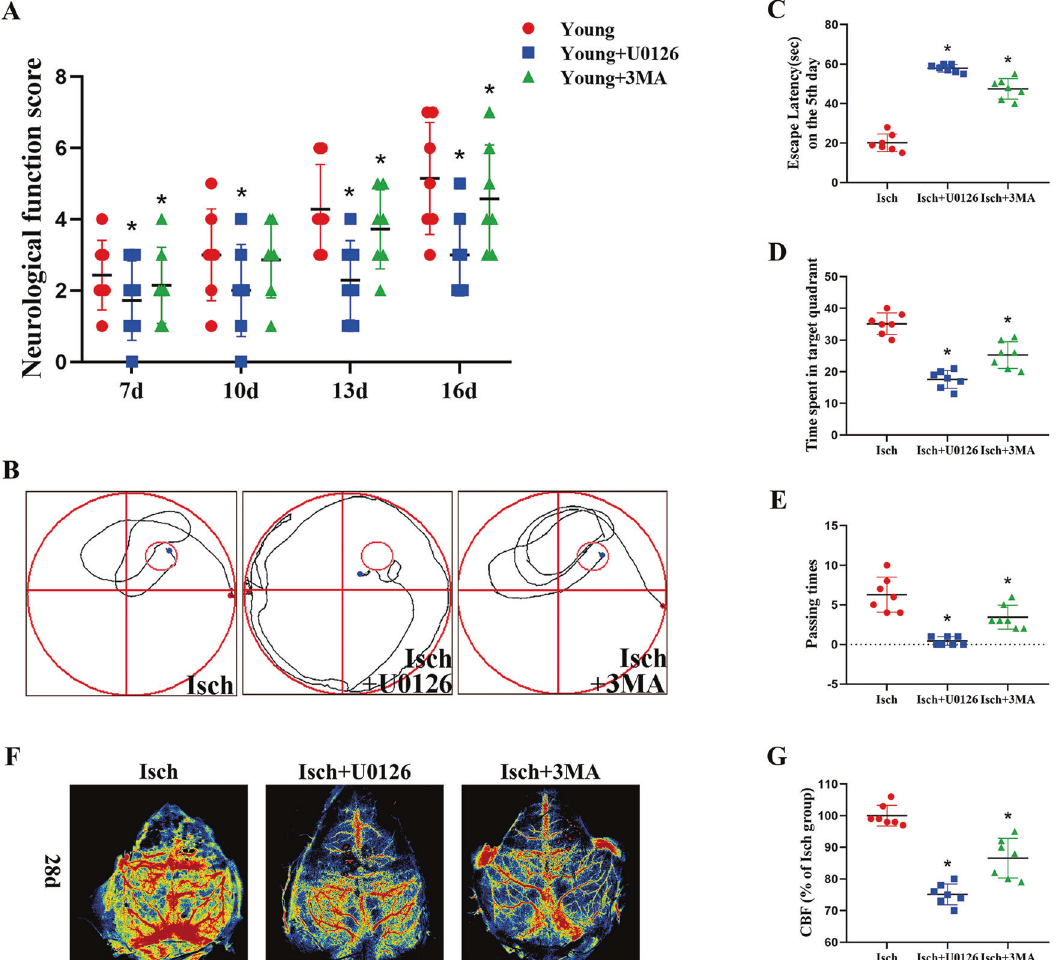
Fig. 4 Change of neurological function and recovery by U0126 or 3MA treatment. Neurological-function score of young gerbils treated with U0126 or 3MA after I/R ( A ). The maps of computer printouts of the swimming trajectories on the fi fth day of each group ( B ). The escape latency on the 5th day of each group ( C ). The time spent in target quadrant on the last day of each group ( D ). Number of crossings over the original platform position by gerbils ( E ) ( n = 7 per group; * p < 0.05, signi fi cantly different from the young group at the same reperfusion time). Bars indicate mean ±